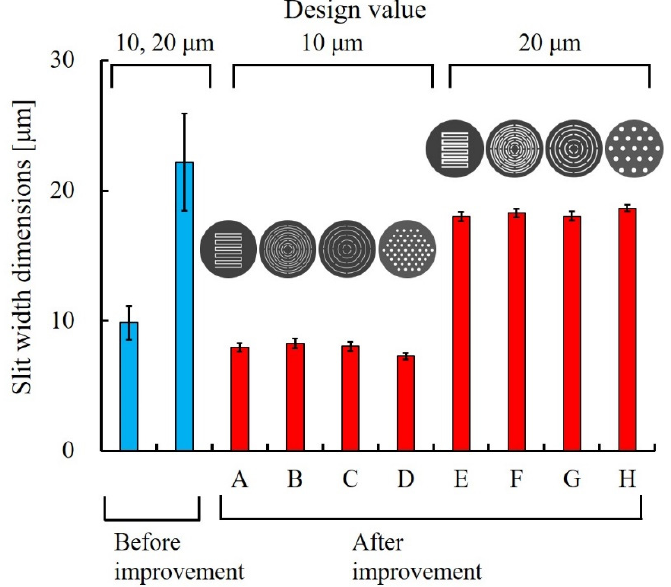
Figure 9. Photographs of the fabricated Ni structures. Eight types of Ni structures were fabricated precisely. Metal structures that deform three-dimensionally of Types A–C and E–G return to the original state even when deformed by hydrodynamic force. Metal structures of Types D and H are formed using the same processes and materials as metal structures that deform three-dimensionally and do not deform into three-dimensional shapes. All types appear warped under the light from the digital microscope, but the Ni structures are not warped after electroforming.